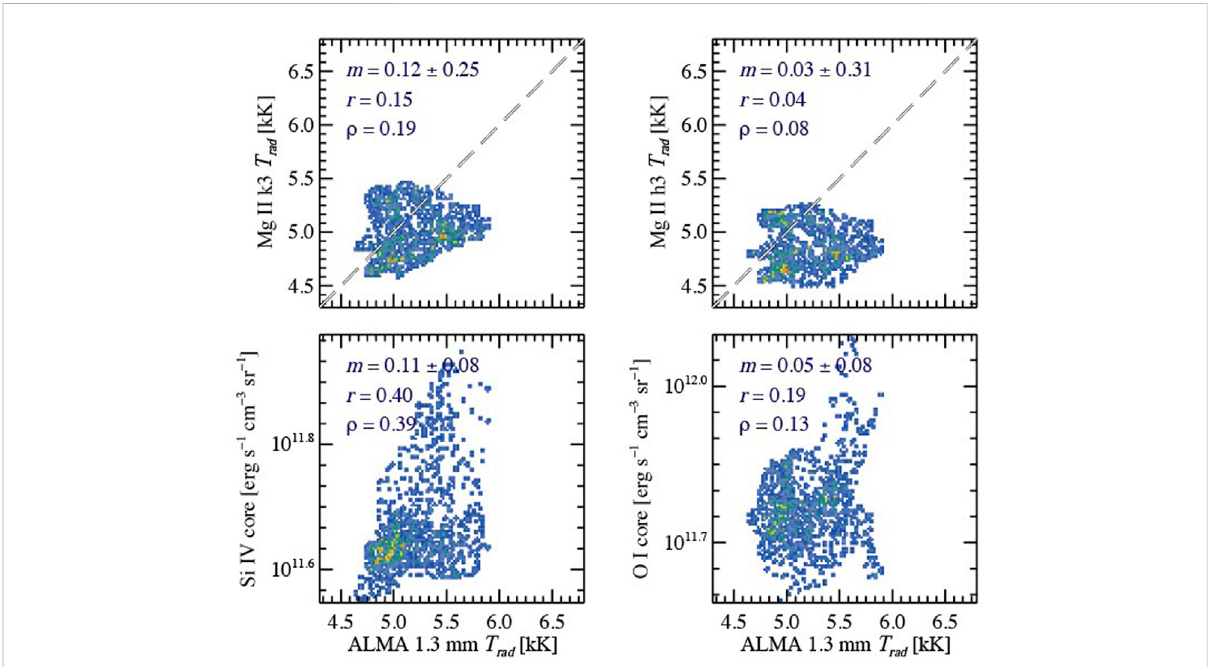
FIGURE 7 ScatterplotsofradiationtemperaturesforIRISNUVandFUVlinefeaturesversustheALMA 1.25 mmbrightnesstemperatureslimitedtopixelsin the umbral region. The density of the scatter points is denoted with the colours: the highest density number is coloured in red, the lowest density in dark blue. The regression slope of the linear fi t (m), the Pearson correlation coef fi cient (r), and the Spearman ’ s rank correlation coef fi cient are listed for each relationship. From Jafarzadeh et al. (2019).Reproduced with permission ⓒ